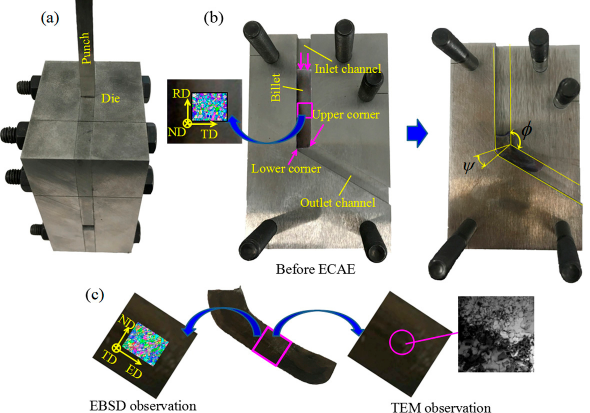
Figure 1. Experimental illustration of equal-channel angular extrusion (ECAE): ( a ) ECAE die; ( b ) process of ECAE; ( c ) sampling location for analysis (In the case of as-received sample, TD, RD, and ND represent the transverse direction, the rolling direction, and the normal direction. In the case of ECAE sample, ED, TD, and ND represent the extrusion direction, the transverse direction, and the normal direction, respectively. TEM: Transmission electron microscopy; EBSD: Electron backscattered diffraction).